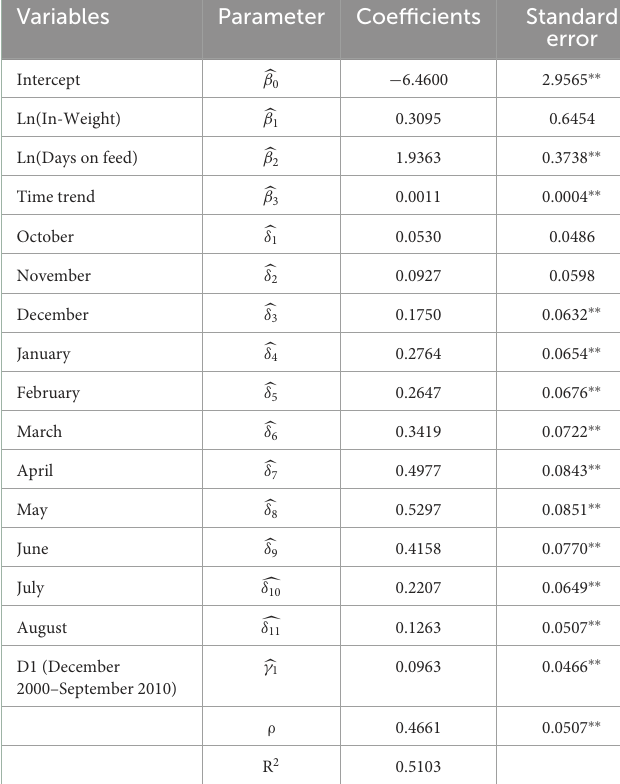
TABLE 5 Parameter estimates for Kansas feedlot death loss rate model with structural change parameter (Equation 11), January 1992–July